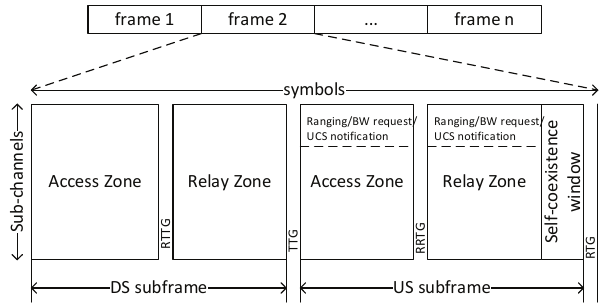
Figure 2. IEEE P802.22b general frame